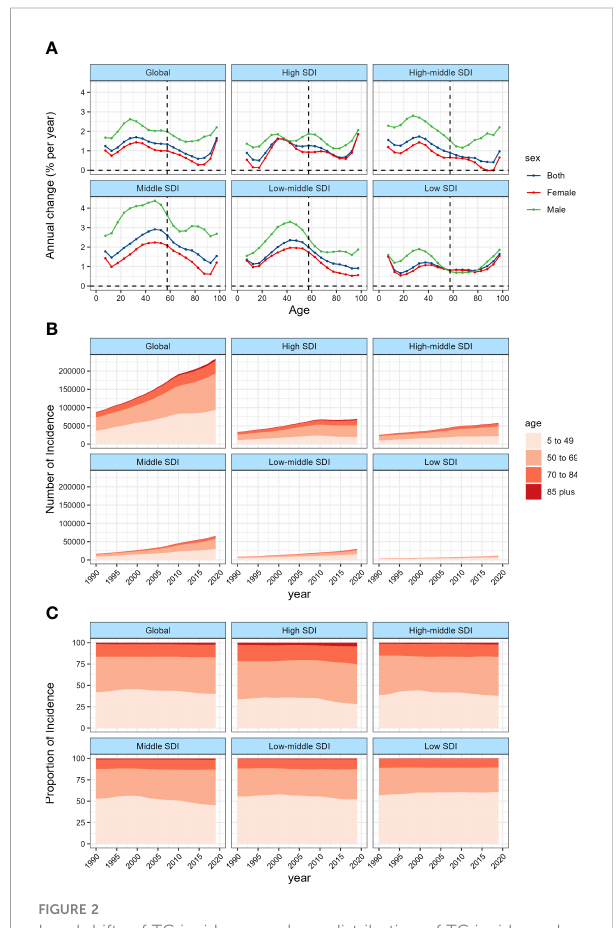
FIGURE 2 Local drifts of TC incidence and age distribution of TC incidence by SDI quintiles, 1990 − 2019. (A) Local drifts of TC incidence (estimates from APC models) for 19 age groups (5~9 to 95 plus years), 1990~2019. The dots and shaded areas indicate the annual percentage change of incidence (% per year) and the corresponding 95% CIs. (B) Temporal change in the absolute cases of TC incidence across age groups, 1990~2019. (C) Temporal change in the relative proportion of TC incidence across age groups,